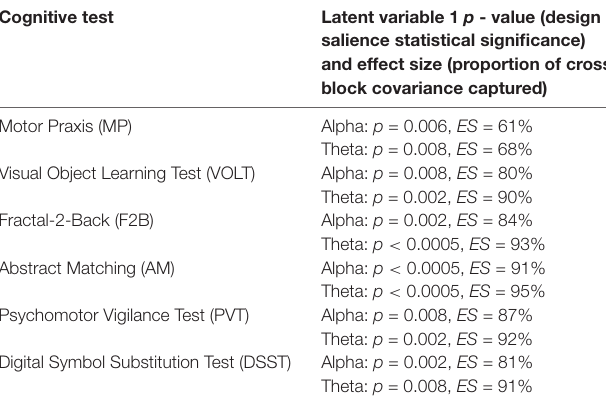
TABLE 2 | Partial Least Squares (PLS) variation three permutation and bootstrapping results for alpha and theta bands. Cognitive test Latent variable 1 p - value (design salience statistical significance) and effect size (proportion of cross block covariance